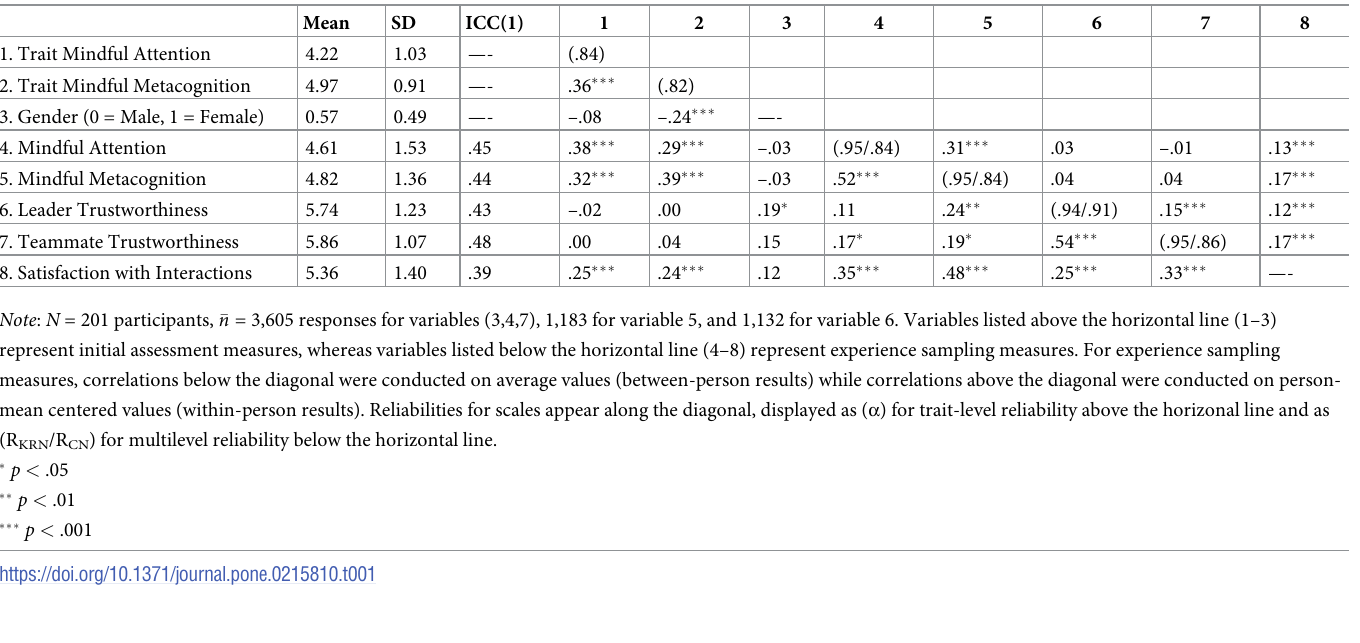
Table 1. Descriptive statistics and correlations among study